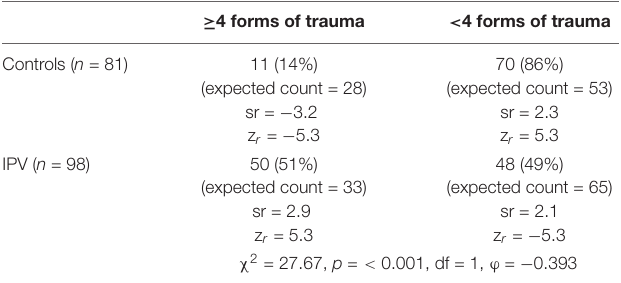
TABLE 9 | Presence of multiple forms of childhood trauma in the IPV and control group. ≥ 4 forms of